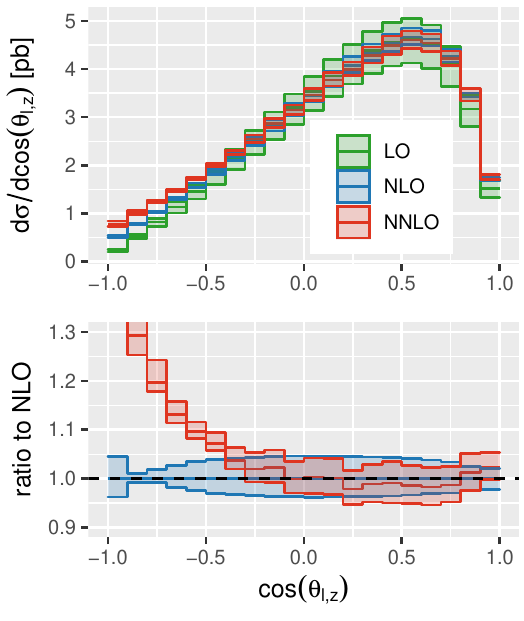
Figure 16 . Angular distribution for cos θ l,z